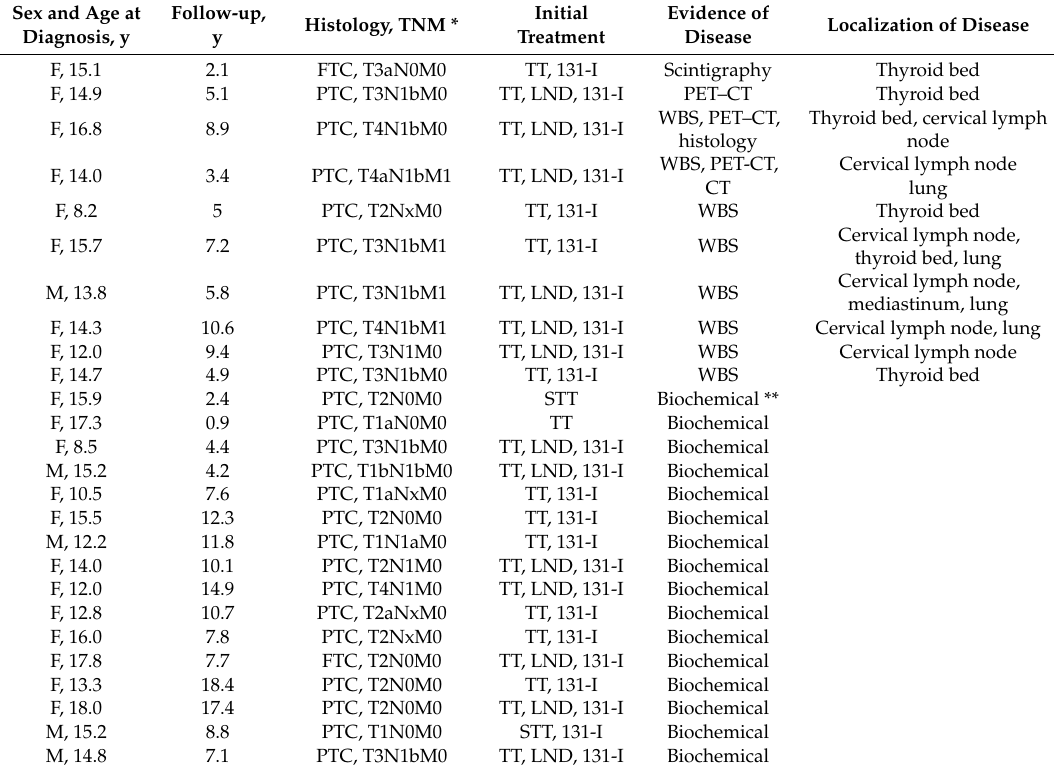
Table 5. Patients with persistent